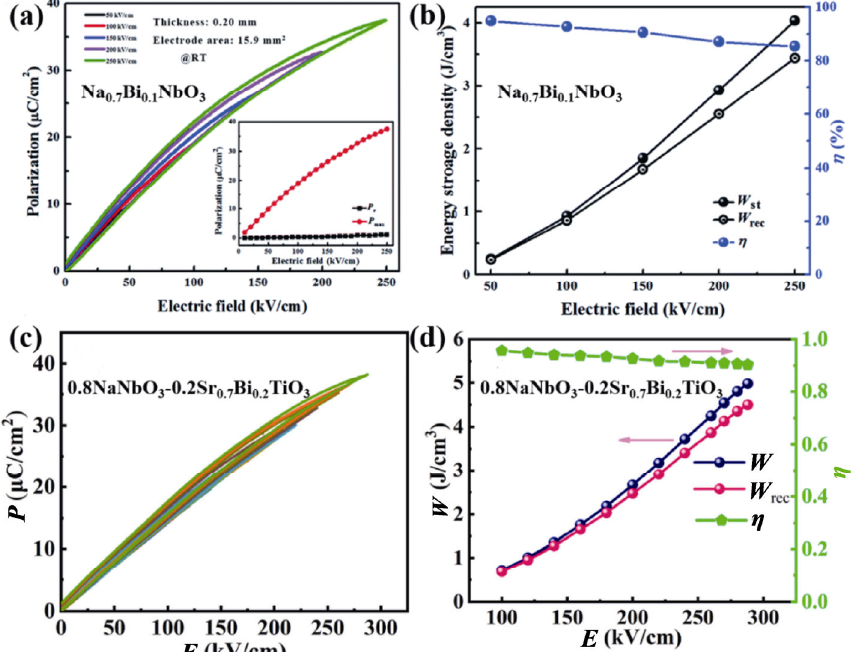
Fig. 13 (a) P – E loops and (b) energy-storage properties of NBN ceramic at room temperature. Reproduced with permission